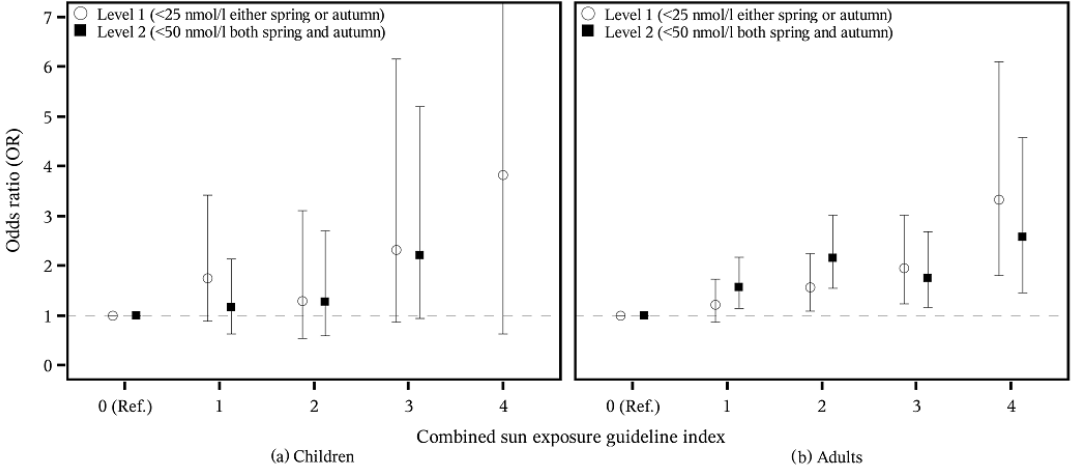
Figure 2. Adherence to the combined sun exposure guideline index and odds ratio (OR) and 95% CI of having low vitamin D (levels 1 and 2) among children, n = 569 ( a ) and adults, n = 2625 ( b ).